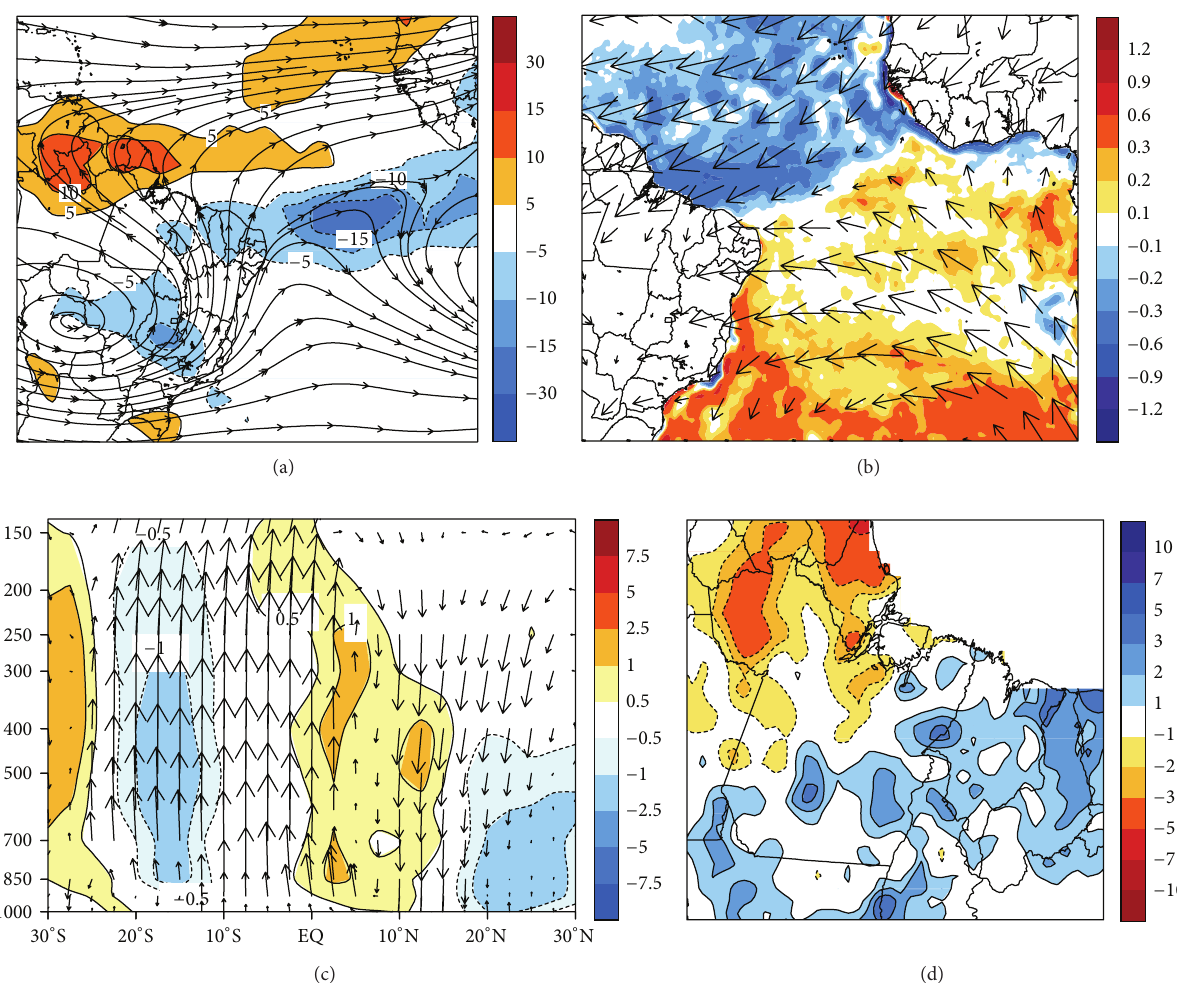
Figure 5: As in Figure 4, but for March composites, corresponding to the objectively selected events in the EOF2.